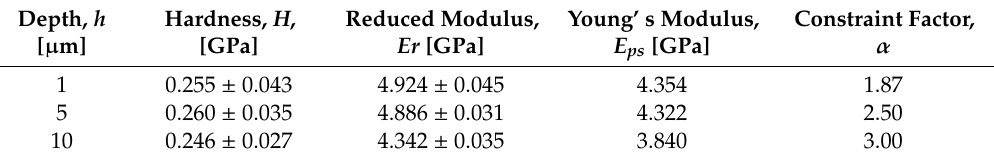
Table 2. Experimental hardness, modulus, and indentation stress constraint factor, 𝛼 , as a function of maximum depth.